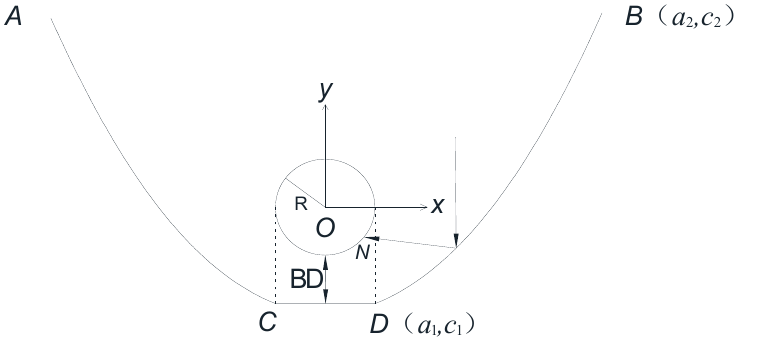
Figure 3. Schematic of a SUC model.